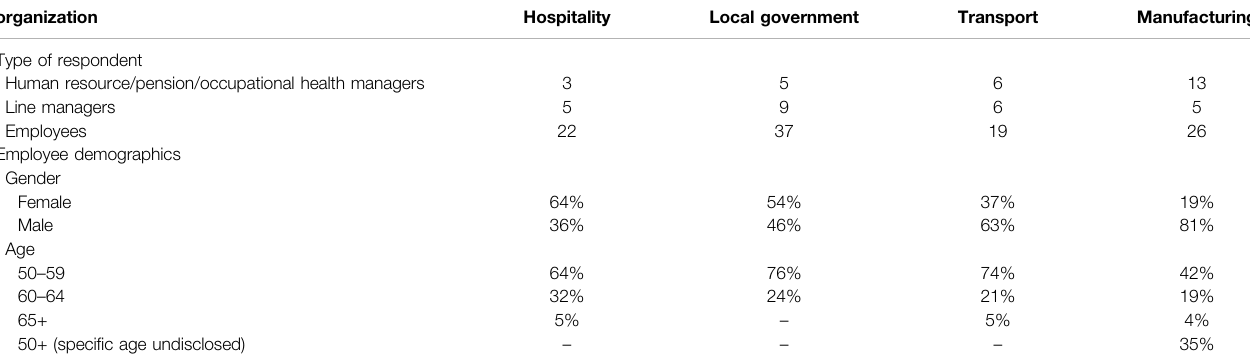
TABLE 1 | Number of participants by case study organization and employee